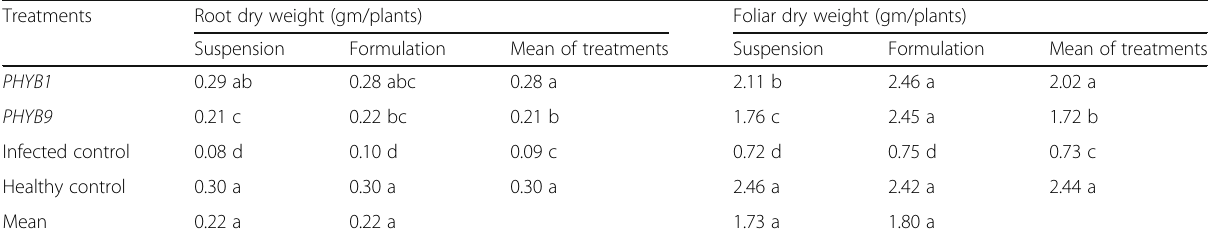
Table 1 Effect of Bacillus simplex as suspension and/or formulation on root and foliar dry weight under greenhouse conditions Treatments